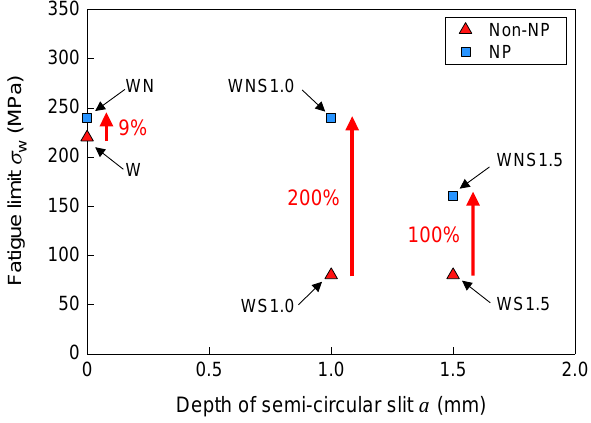
Figure 6. Relationship between the fatigue limit and the semicircular slit depth. The fatigue limit was defined as the maximum stress amplitude at which the specimen could endure 1 × 10 7 cycles.